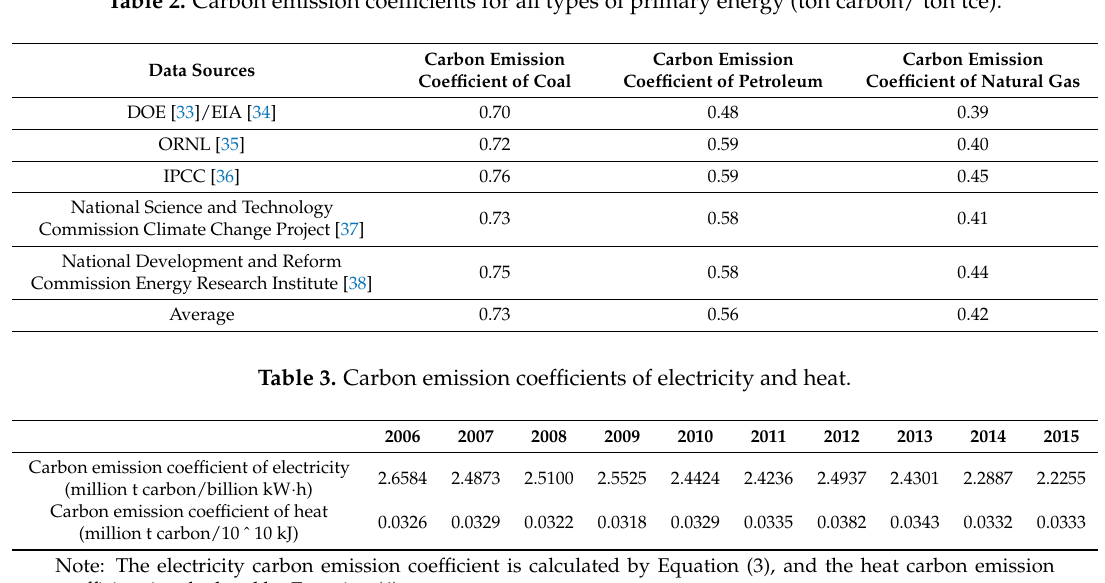
Table 2. Carbon emission coefficients for all types of primary energy (ton carbon/ ton tce).